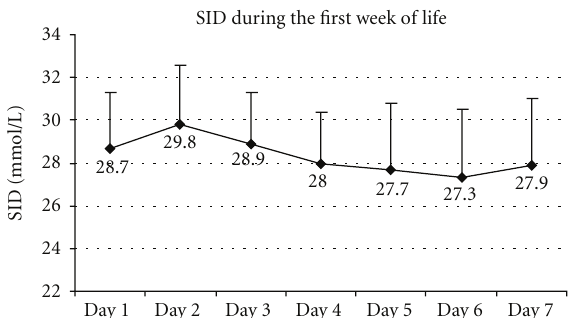
Figure 3: Strong ion di ff erence (SID) during the first week of life in 107 infants < 33 weeks of GA hospitalized in NICU ( P value = 0.000001 at Kruskal-Wallis one way analysis of variance).